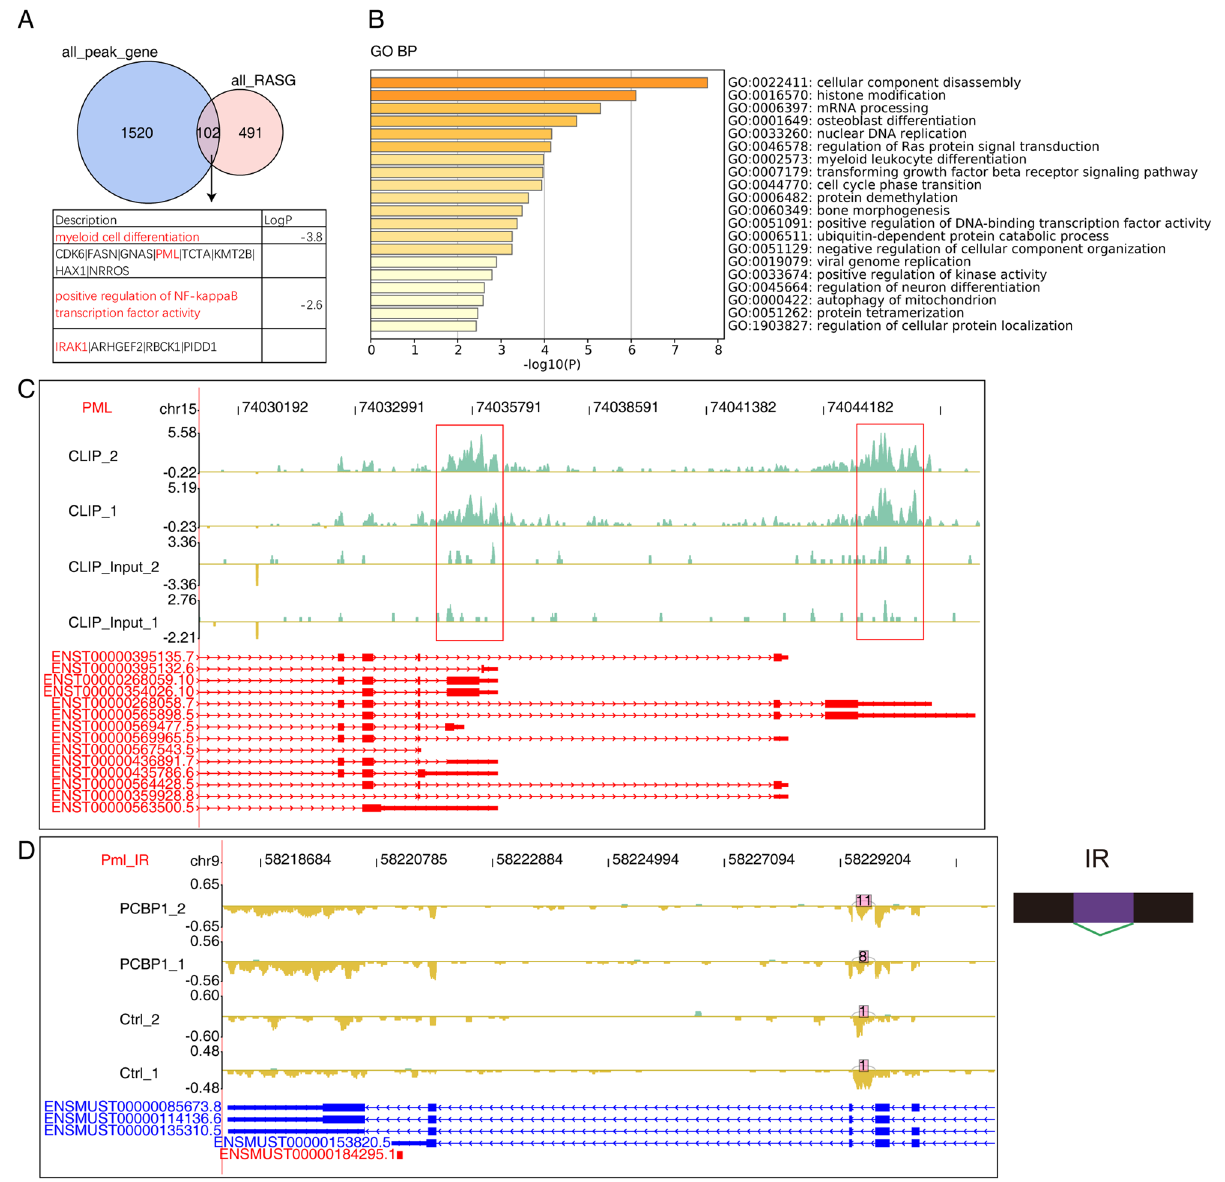
Figure 5. PCBP1 selectively binds to mRNA to regulate alternative splicing. ( A ) Venn diagram showed the overlap of PCBP1-bound peak’s genes and PCBP1-regulated alternatively splicing genes, and the PCBP1-bound peak’s genes is the union of two IP samples. LogP: log2 pvalue of enrichment terms. ( B ) Bar plot exhibited the most enriched GO biological process results of the overlap peak’s genes in figA, that making use of analyses by Metascape. ( C ) IGV-sashimi plot showed the UPF1-bound sites across mRNA of PML. The transcript of the gene was plotted at the bottom of the graph. ( D ) IGV-sashimi plot showed the UPF1-regulated alternative splicing events across mRNA of Pml. The transcript of the gene was plotted at the bottom of the graph and on the right was a model diagram of splicing